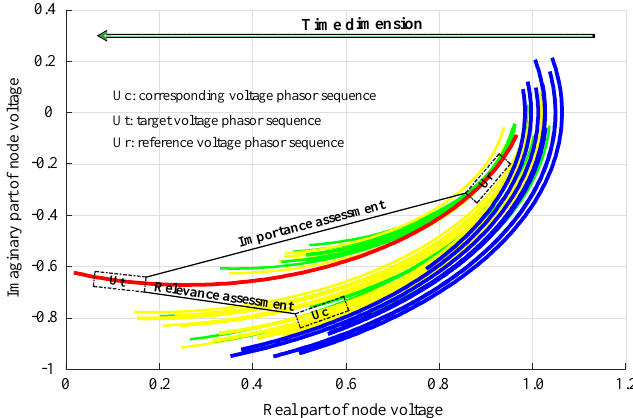
Figure 2. Node voltage trajectories.